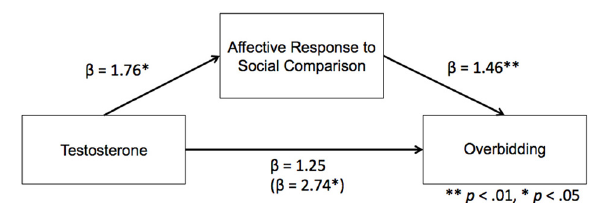
FIGURE 5 | Mediation of testosterone, affective responses to social comparison and competitive overbidding. For illustration purposes we have added the betas of the classical (Baron and Kenny, 1986) regression method to test for mediation. The results, which are completely consistent with the bootstrapping methods reported in the results section, show that the relation between testosterone and competitive overbidding is mediated by affective responses to social comparisons. For more detail on moderation effects of cortisol see